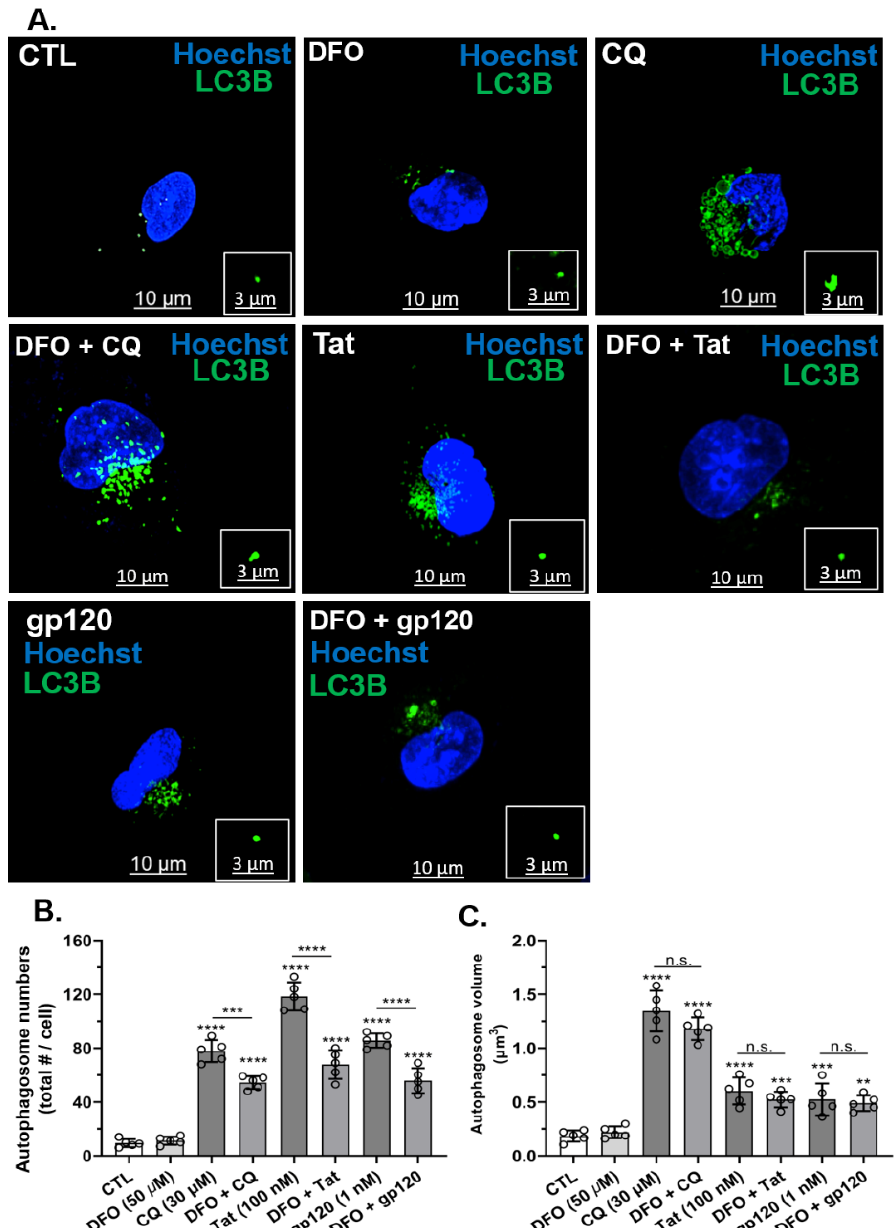
Figure 3. DFO blocked HIV ‐ 1 Tat ‐ , gp120 ‐ and CQ ‐ induced increases in autophagosome numbers but not volumes. ( A ) Representative fluorescence microcopy images of autophagosomes (LC3B, green) and nuclei (blue). Qualitatively, DFO blocked CQ ‐ , HIV ‐ 1 Tat ‐ and gp120 ‐ induced changes in autophagosome numbers and volume. ( B , C ) Quantitatively, CQ (30 μ M), Tat (100 nM), and gp120 (1 nM) increased autophagosome numbers and volume, and DFO significantly ( p < 0.0001) decreased autophagosome formation but did not reduce changes in autophagosome volumes. Image analysis and quantification were performed from five independent experiments with 30 cells quantified for each experimental condition ( n = 150). Error bars represent standard deviation (SD) of five independent experiments. A one ‐ way ANOVA multiple comparisons test was used to compare data from control and treatment groups. Cells were chosen randomly during image acquisition and anal ‐ ysis from the microscope field of view, and no cells were intentionally excluded. Scale bars are 10 μ m for the image and 3 μ m for the inset. ** p < 0.01, *** p < 0.001, and **** p < 0.0001; n.s.: non ‐ significant .